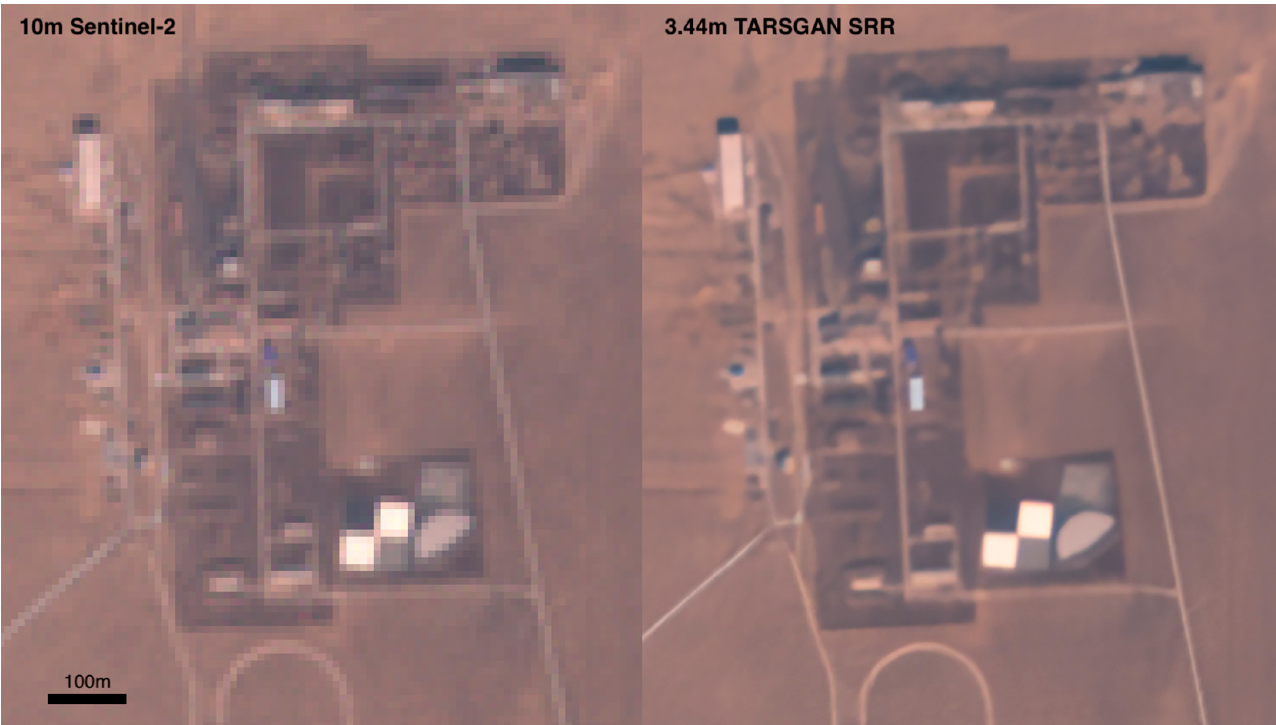
Figure 1. An example of the 10m/pixel Sentinel-2 “true” colour image and the 3.44m/pixel TARSGAN SRR results over a geo-calibration site at Baotou, China (Sentinel-2 image ID: S2A_MSIL1C_20171031T032851_N0206_R018